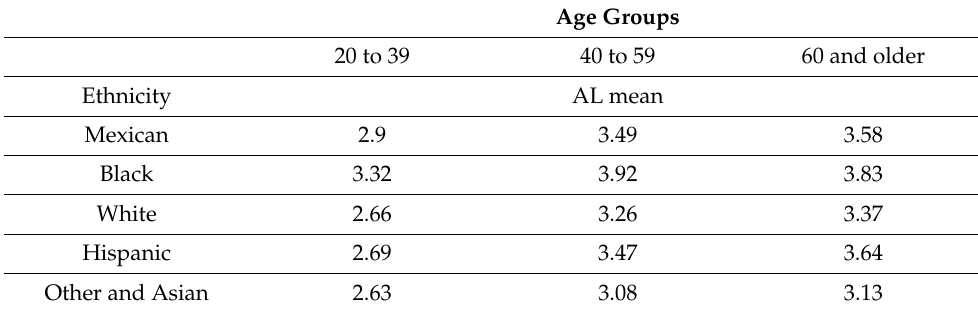
Table 3. AL means for ethnicities by age group.